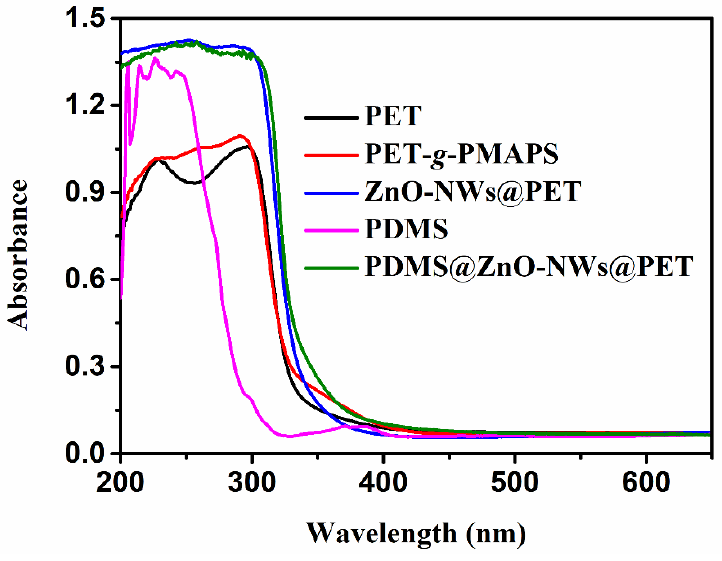
Figure 4. UV ‐ vis absorption spectra of pristine PET fabric, PET ‐ g ‐ PMAPS, ZnO ‐ NWs@PET, and